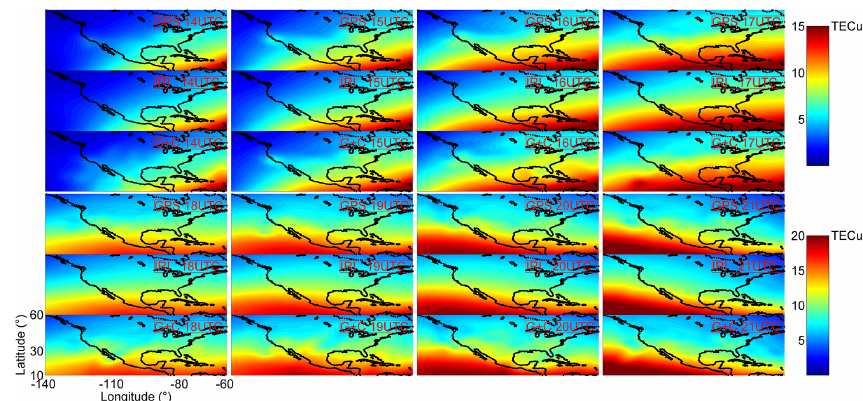
Figure 4. The DA and background model IRI TEC map of the North American Continent at daytime (14:00 to 17:00UTC, top three rows) and 18:00 to 21:00UTC (bottom three rows). Each time period has three different TEC maps, including a DA TEC map using ground-based GPS data, an IRI TEC map, and a DA TEC map using ground-based GPS and F3/C RO data.